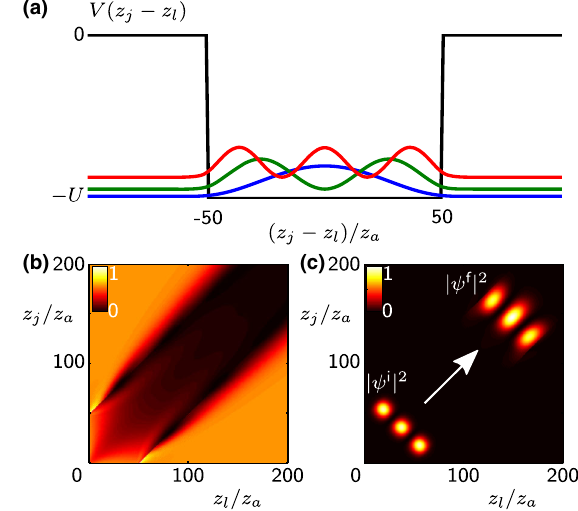
200 atoms on a FIG. 3. EIT in atomic medium with N a ¼ lattice with lattice constant z and interaction H P a ss ¼ − ℏ σ j σ l − z V ð z . (a) The potential is chosen to be a ss j l Þ ss j ≠ l − z − 0 . 5 Γ 0 square well, with an interaction strength of V ð z j l Þ ¼ − z < 50 z for atoms with separation j z and zero otherwise. j l j a The colored curves show the three lowest energy states of the step potential. (b) When the system is driven continuously so that 2 ¼ 10 − 4 Γ 0 ), the majority of the steady-state spin δ ¼ 0 ( j E i j population j ψ j;l ss j 2 (arbitrary units) is in pairs of excitations with j z j − z l j > 50 z a . (c) Propagation of a two-photon wave function (arbitrary units) in which the relative coordinate is initially prepared as the third harmonic eigenstate [red curve in (a)] of the square-well potential. Here, the final spin population is multiplied by a factor of 100, so both initial j ψ i j 2 and final j ψ f j 2 are visible on the same scale. Other simulation parameters Γ 0 (optical depth D ¼ 400 ), and Δ ¼ 0 used are Ω ¼ 2 Γ 0 , Γ 1 D ¼